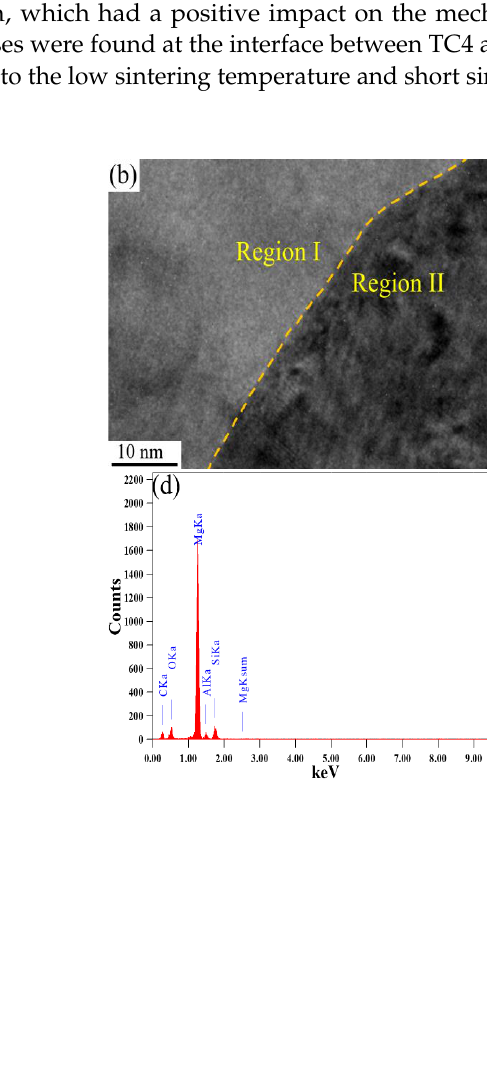
Figure 9. KAM map and KAM value distribution chart of ( a ) AZ31, ( b ) 0.5 wt.%TC4/AZ31, ( c ) 1 wt.%TC4/AZ31, and ( d ) 1.5 wt.%TC4/AZ31 as-extruded composites.